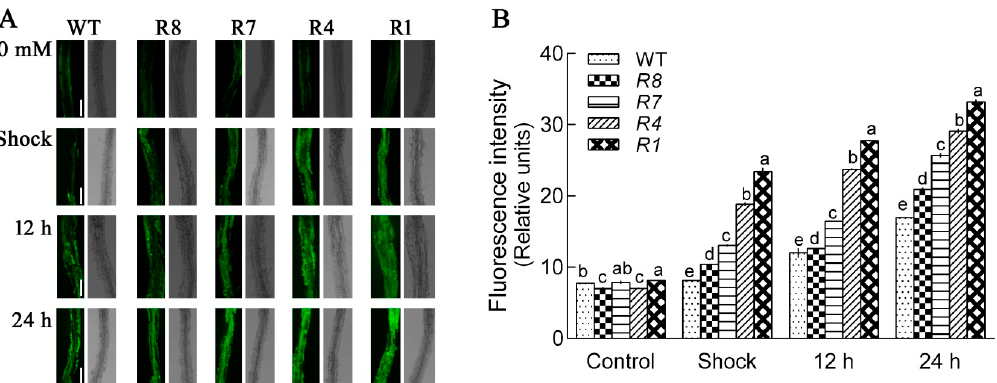
Figure 7. Accumulation of H 2 O 2 in the root tips of GL1 and CPK12 -RNAi plants exposed to salt stress. ( A ) After germinating seven days, the Arabidopsis seedlings were transferred to MS medium containing 0 or 100 mM NaCl for 10 min, 12 h, or 24 h. These seedlings were incubated with H 2 DCF-DA for 5 min. The green fluorescence within cells at the apical region of roots was detected using a Leica confocal microscope. Scale bars, 100 μ m. ( B ) The relative fluorescence intensity (±SD) represents the mean of 10 Arabidopsis seedlings. The mean values of H 2 O 2 fluorescence are labeled with letters in the same group to denote significant differences ( p < 0.05).